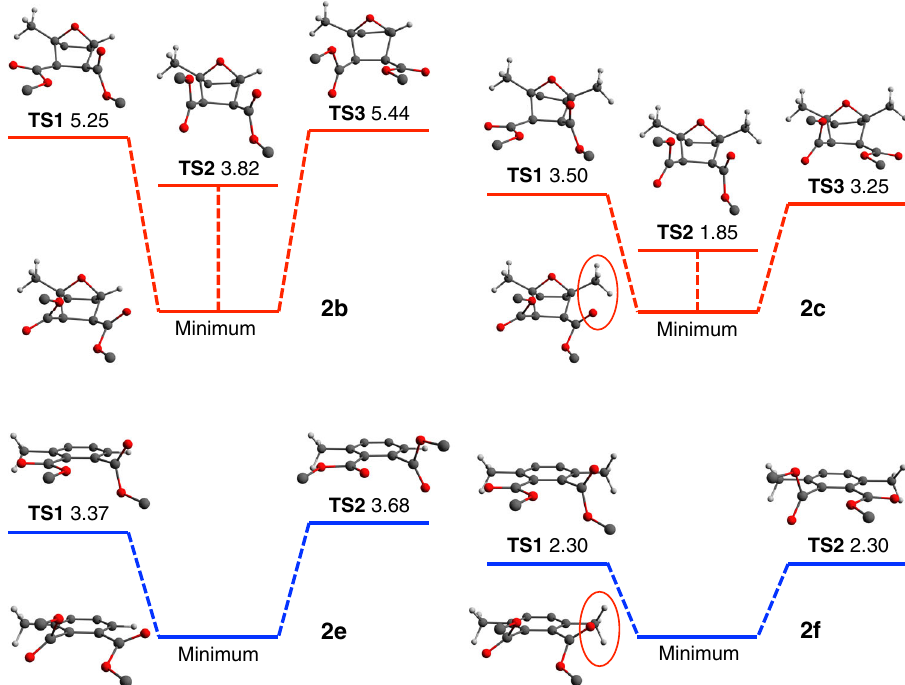
Fig. 5 Stationary point characterization. Structures and relative energetics (in kcal/mol) of the highlighted stationary points on the 2D rotational PES depicted in Fig. 3c for the monomethyl-( 2b , 2e ) and dimethyl-( 2c , 2f ) substituted model compounds. The analogous barriers for the unsubstituted compounds in each series were omitted for clarity and determined to be + 2.01 ( TS1 ), + 2.42 ( TS2 ), + 2.78 ( TS3 ) for 2a and + 1.38 ( TS1 ), + 1.38 ( TS2 ) for 2d . The energetically unfavorable steric strain between ester groups and methyl substituents are indicated with red